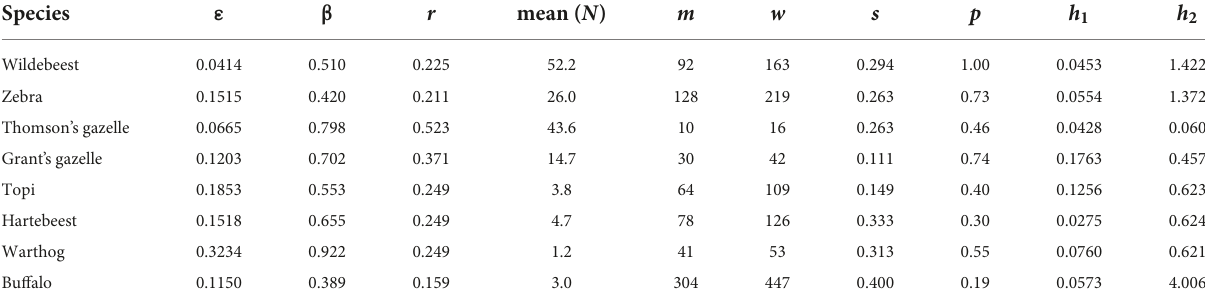
TABLE 1 Parameters for Serengeti group-dependent predator–prey model. Species